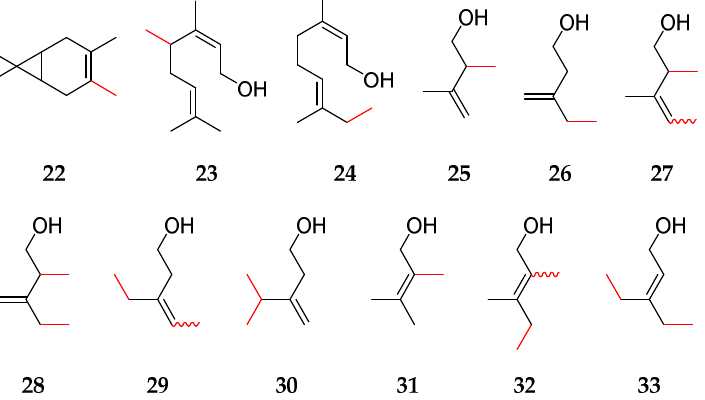
Figure 5. Structures of methylated terpenes with red-labeled bonds to the additional methyl groups: 4-methyl-3-carene 22 , 4-methylnerol 23 , 8-methylnerol 24 , 2-methylisoprenol 25 , 5-methylisoprenol 26 , 2,4-dimethylisoprenol 27 , 2,5-dimethylisoprenol 28 , 4,5-dimethylisoprenol 29 , 5,5-dimethylisoprenol 30 , 2-methylprenol 31 , 2,4-dimethylprenol 32 , and 4,5-dimethylprenol 33 .